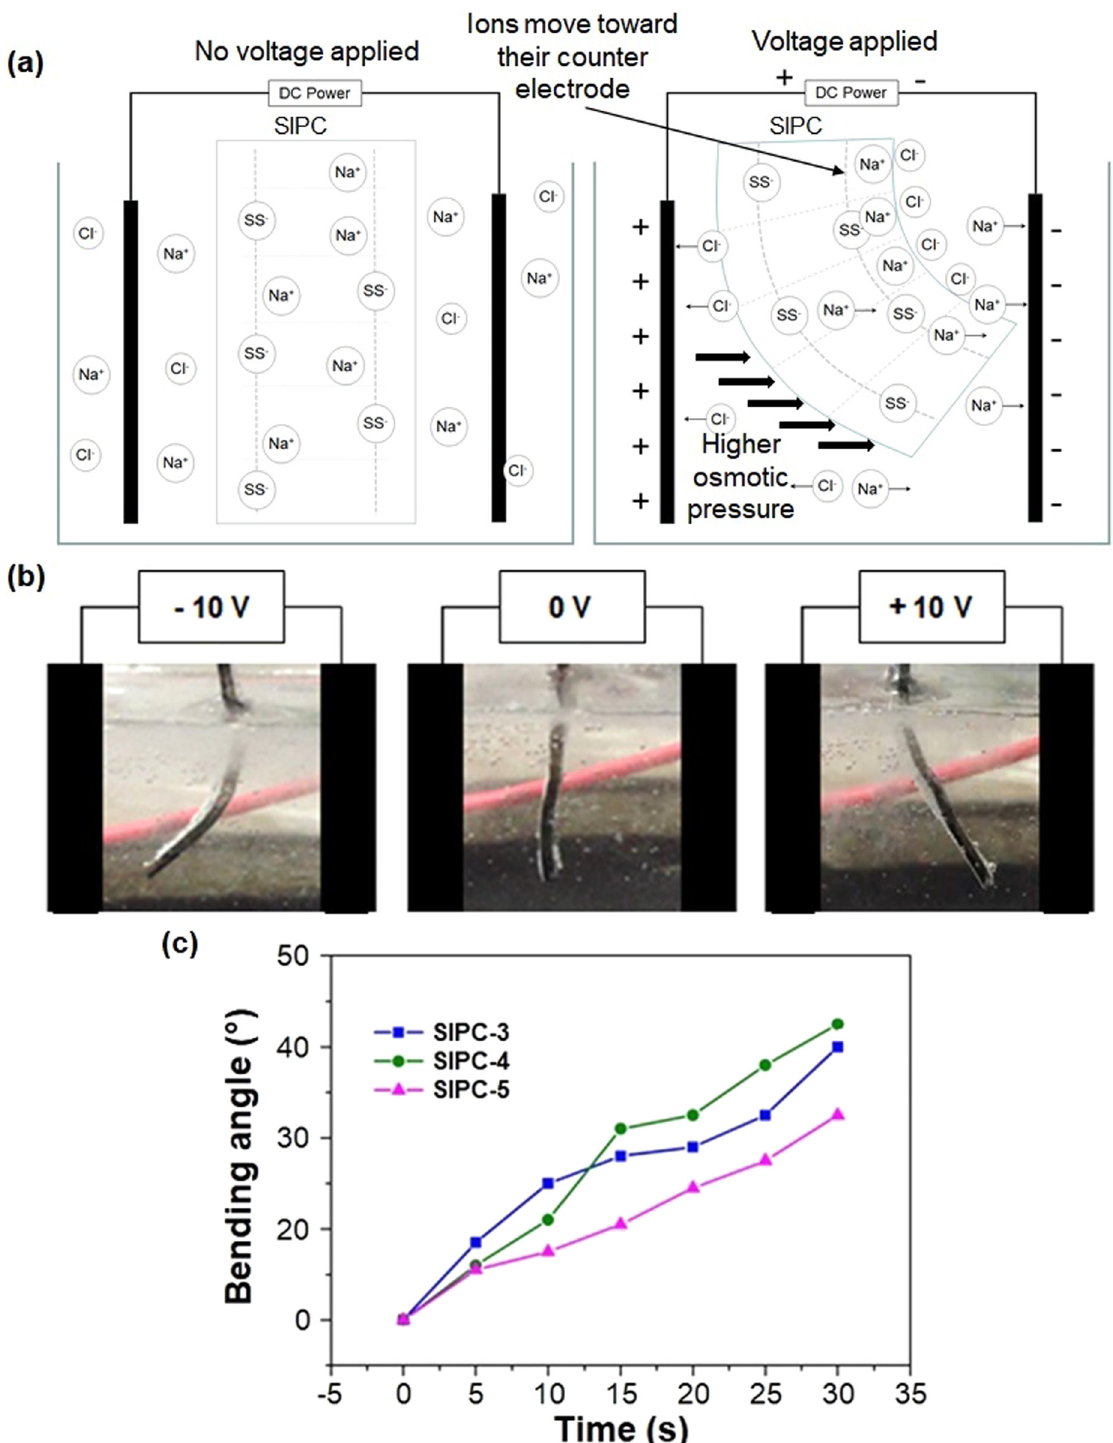
Figure 6: ( a ) Illustration of the bending mechanism and ( b ) bending of the SIPC - 4 hydrogel under applied voltage. ( c ) The electromechanical response of the SIPC